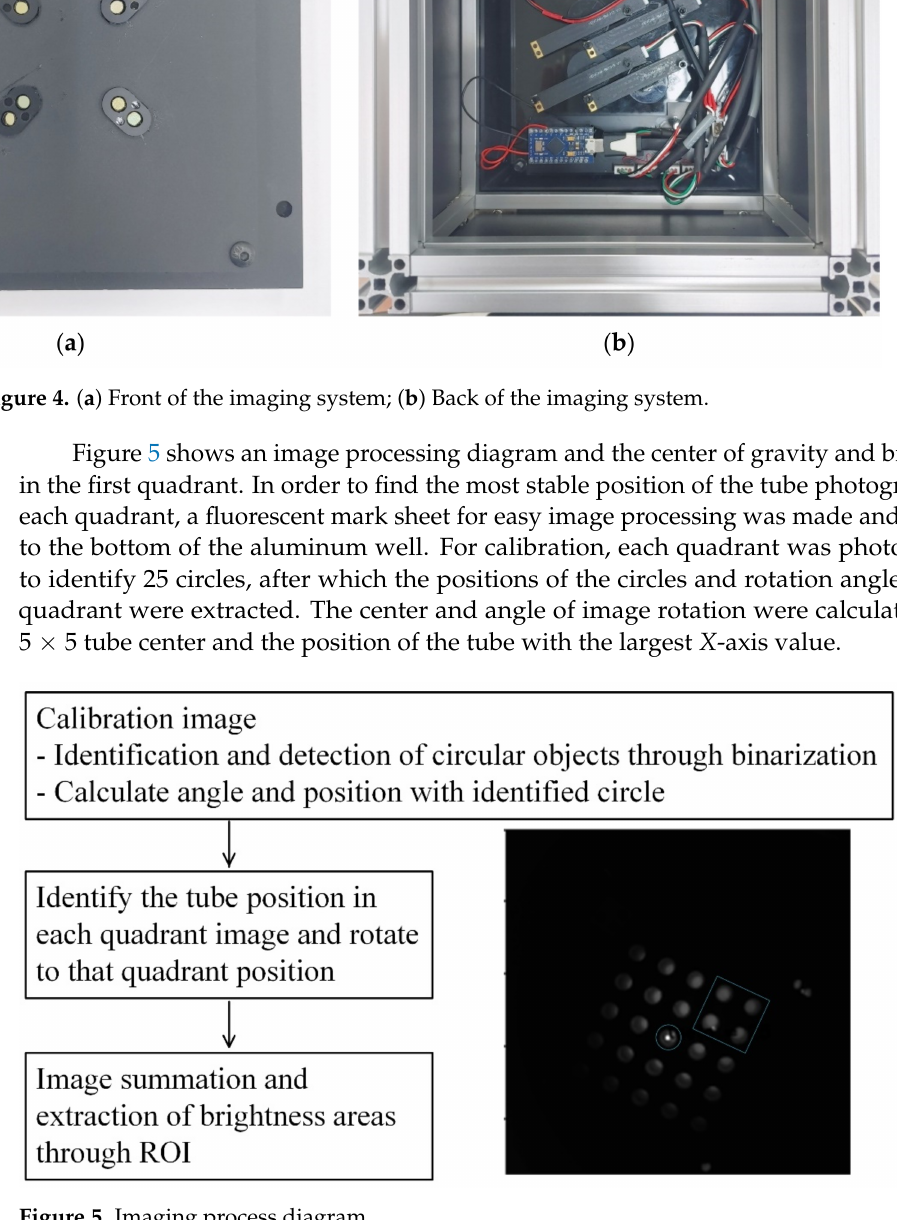
Figure 5. Imaging process